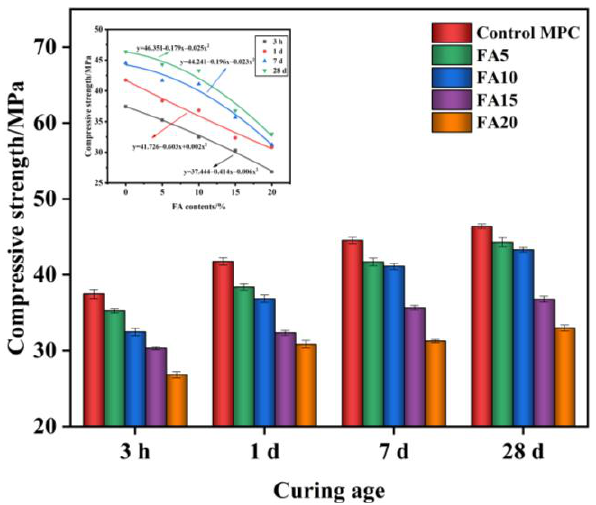
Figure 13. The effect of FA content on MPC compressive strength.